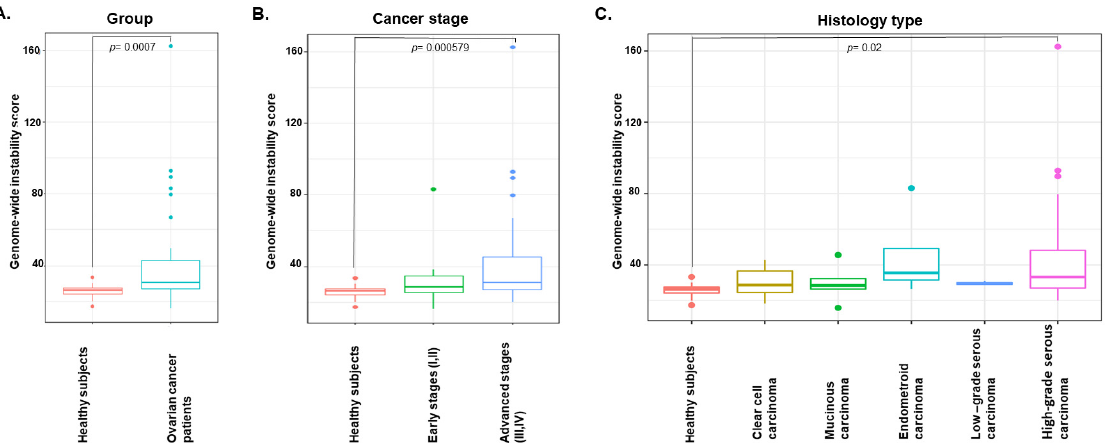
Figure 2. Distribution of genome-wide instability scores according to participant type ( A ) (OC patients vs. healthy subjects), ( B ) cancer stage (stages I/II [early] vs. stages III/IV [advanced]), and ( C ) histology type.